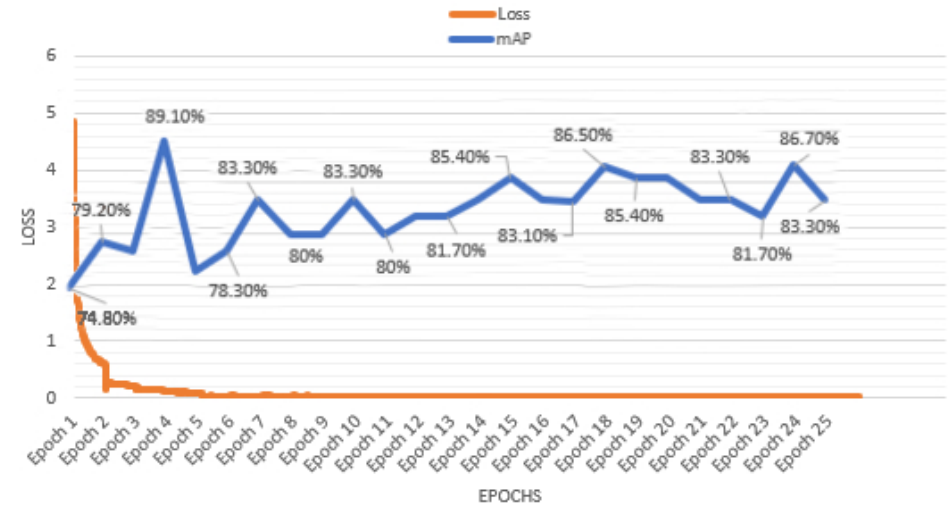
Figure 5. Loss and mAP in the Custom Mask-RCNN model.